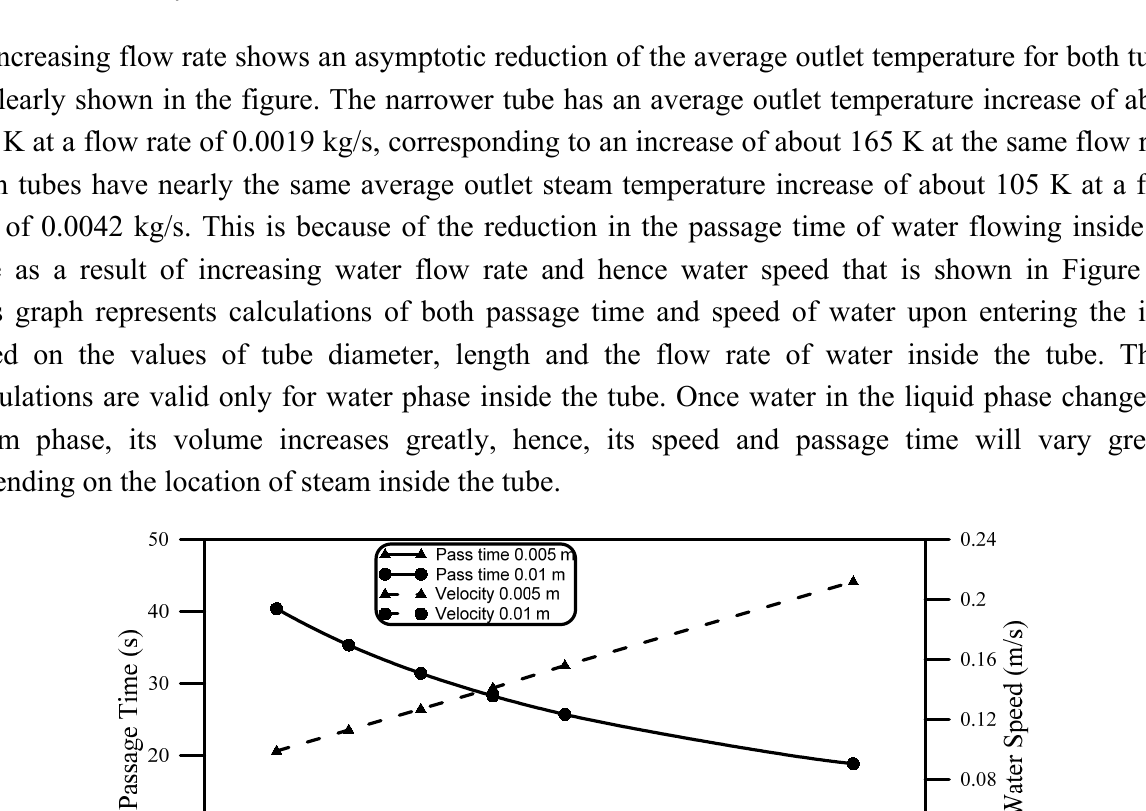
Figure 11. Increase in the average outlet temperature for the 0.005 m and 0.01 m tubes on a summer day.